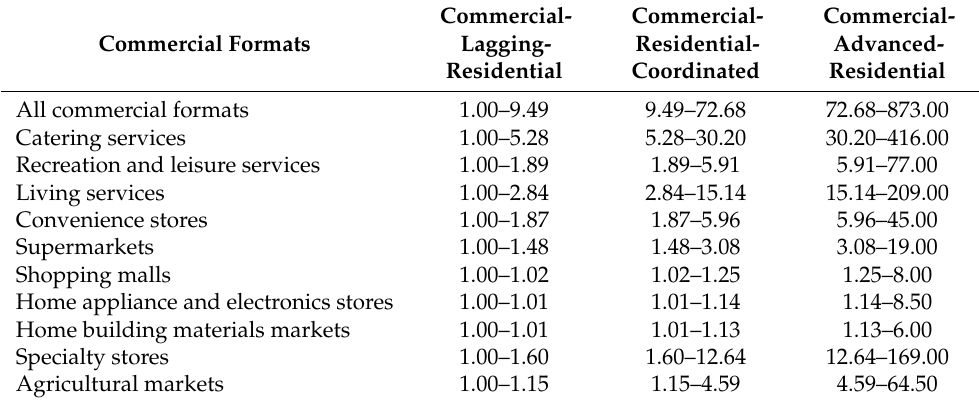
Table 6. Classification standard of association relationships between commercial and residential